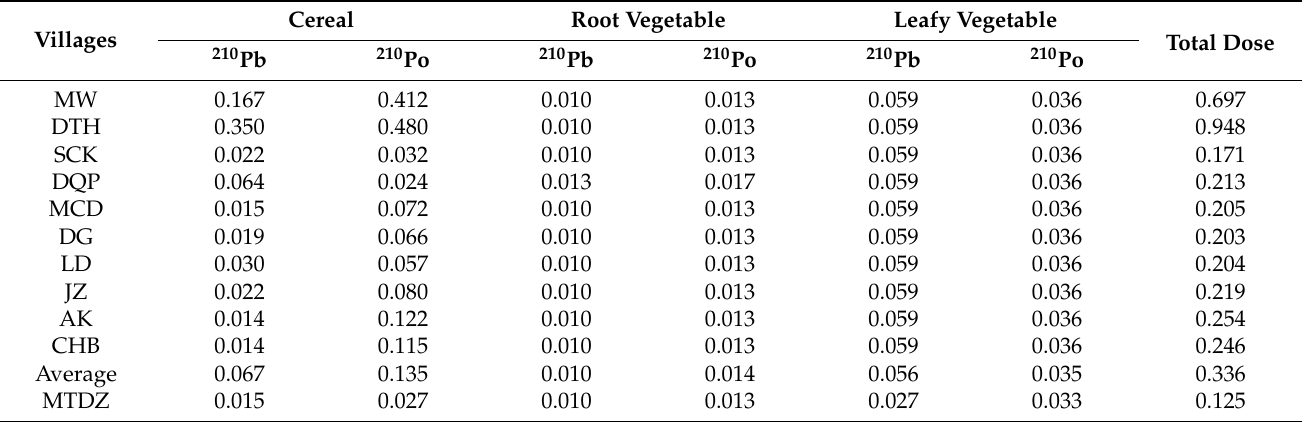
Table 7. The annual ingestion doses (mSv/a) of adults due to the intake of 210 Pb and 210 Po via the consumption of different